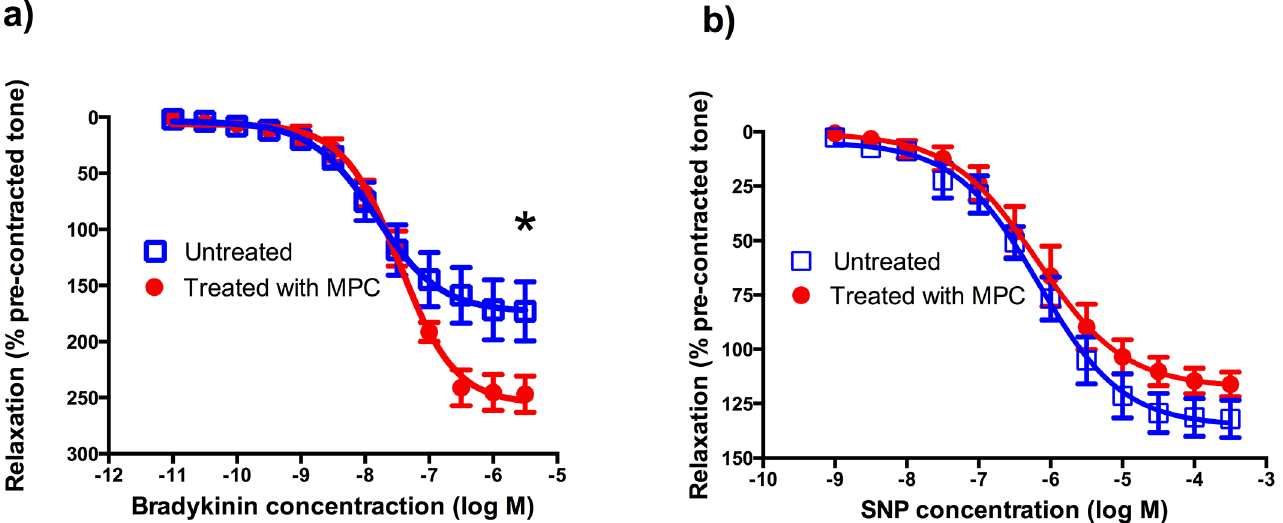
Fig 3. Comparison of vasorelaxation in ovine coronary arteries in arthritic sheep treated and untreated with mesenchymal precursor cells (MPC). Arterial rings were contracted with endothelin-1, and relaxation responses to cumulatively increasing concentrations of (A) Bradykinin (BK), (B) Sodium nitroprusside (SNP), were expressed as a percentage relaxation of pre-contracted tone. Each point represents the mean ± SEM from 8 animals. * Indicates statistically significant difference (p < 0.05) in the maximum response for the dilation to bradykinin between treated and untreated animals (see Table 1).